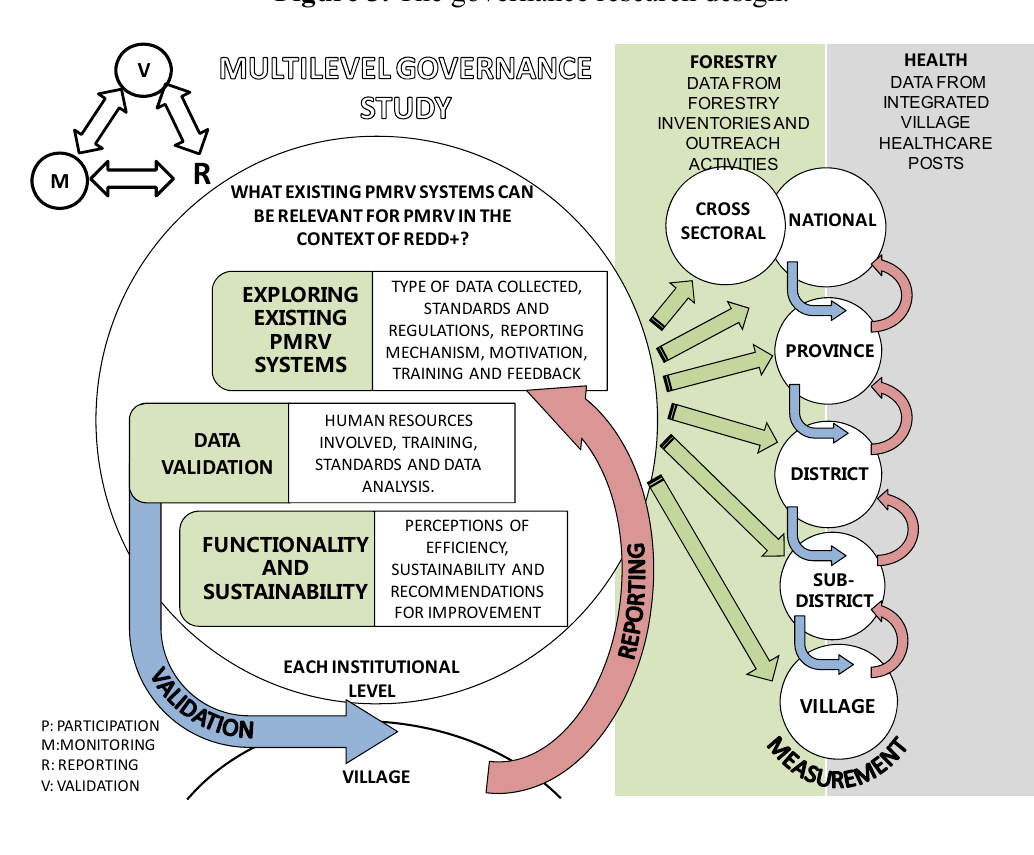
Figure 3. The governance research